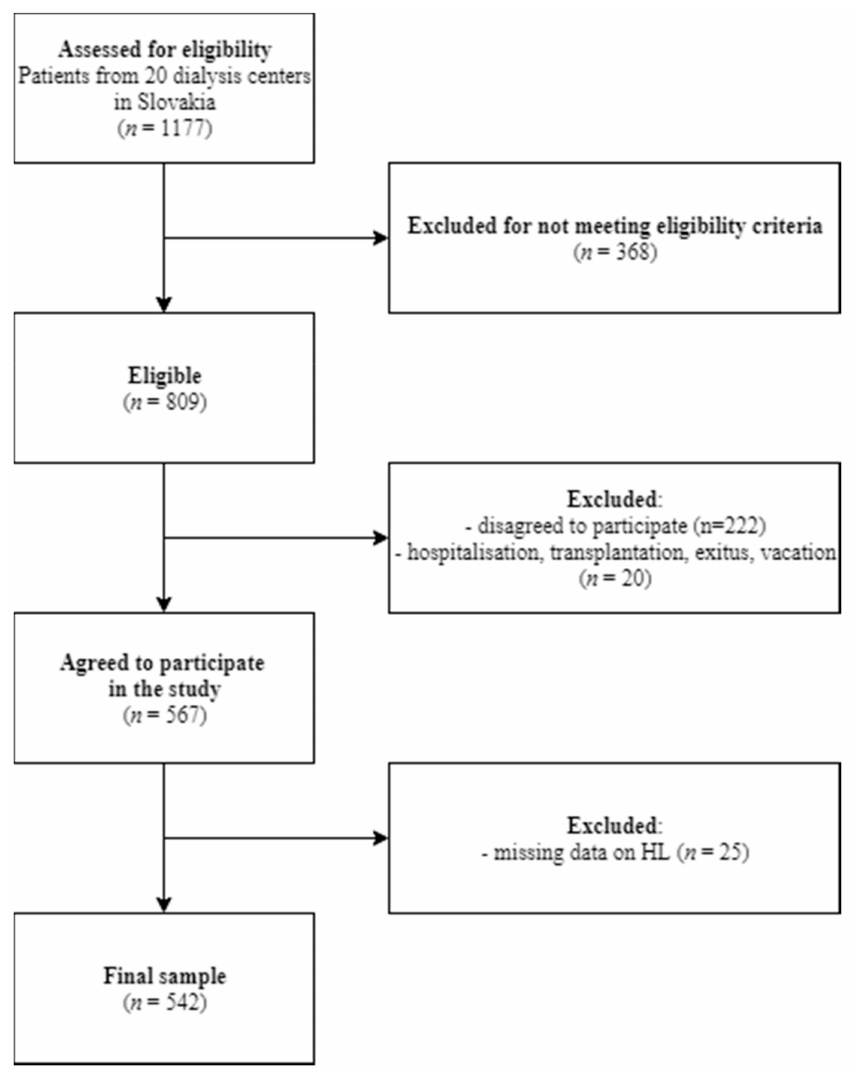
Figure 1. Flow chart related to data